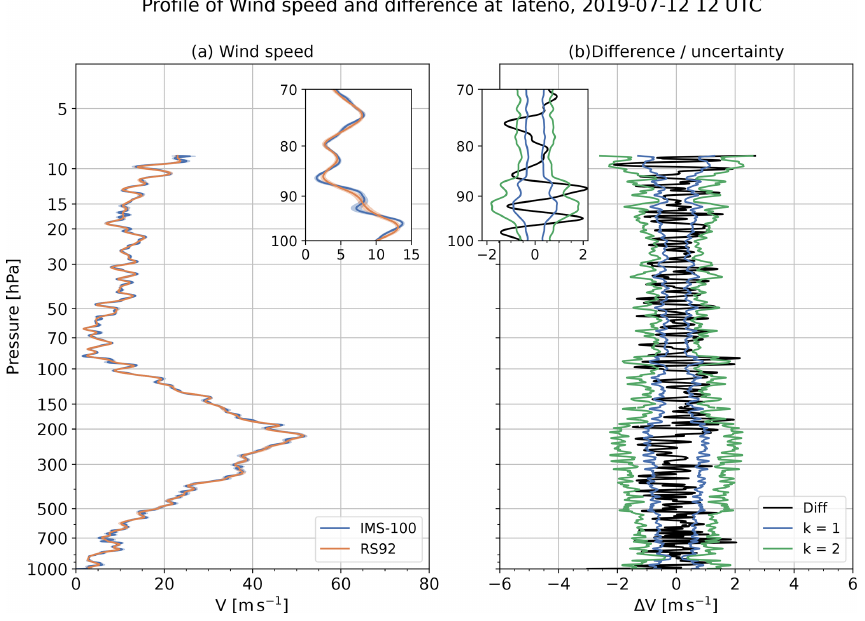
Figure 31. (a) Profiles of wind speed with uncertainty (shades) at 12:00UTC on 12 July 2019. Blue and orange lines represent iMS-100-GDP and RS92-GDP, respectively. (b) Profiles of wind speed difference (iMS-100-GDP minus RS92-GDP; black line) and synthetic uncertainty (blue and green lines for k = 1 and k = 2, respectively) are shown.